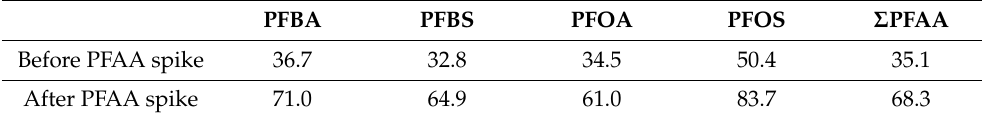
Removal Efficiencies RE ( % ) Calculated Considering the Mass Flows: RE ( % ) = ( 1 − M OUT / M IN ) × 100).